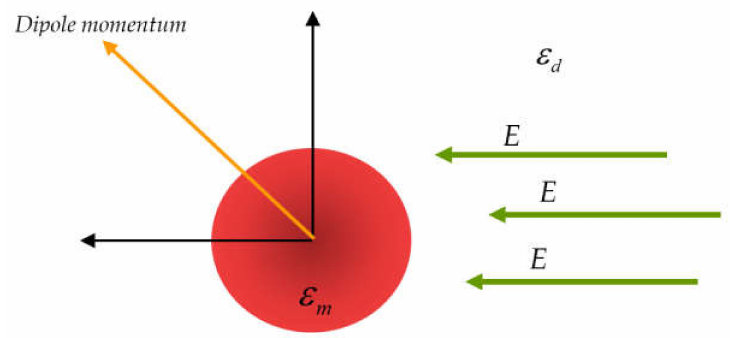
Figure 2. Metal cluster in electrical